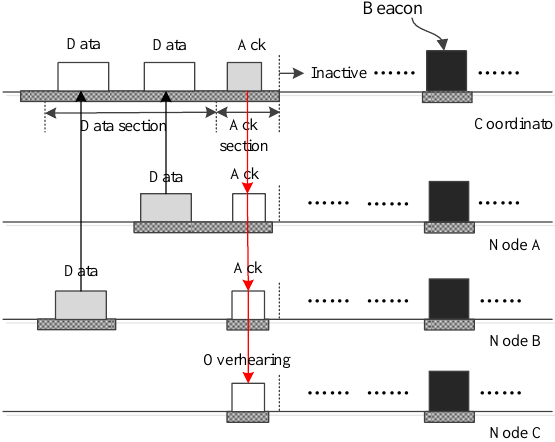
Figure 12. Two nodes send small data to the coordinator.